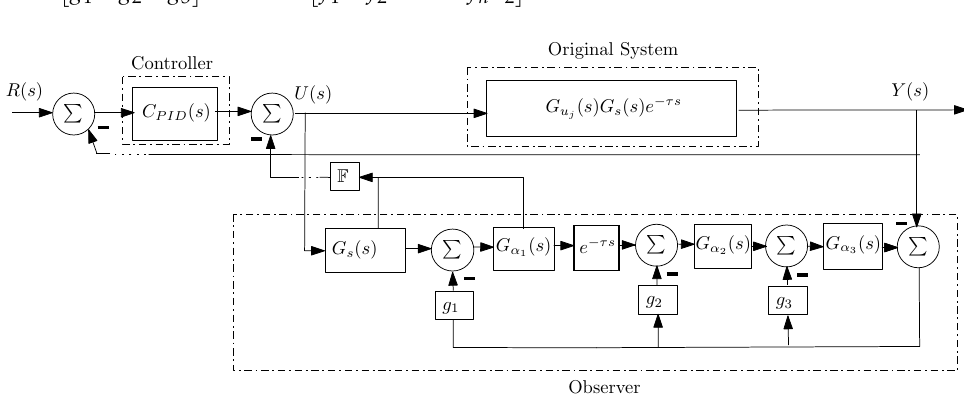
Figure 3. Observer-based PID control